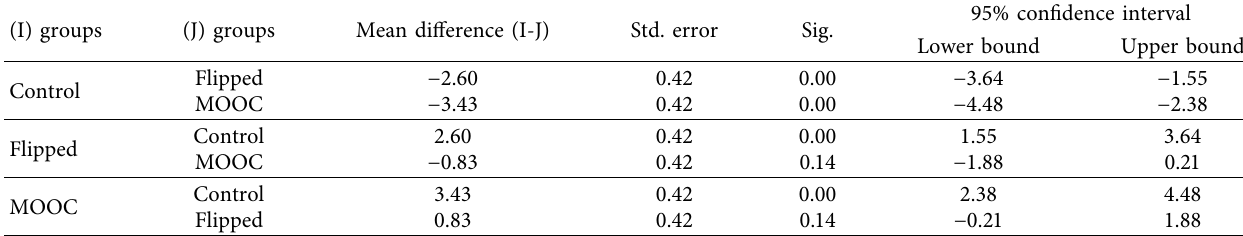
Table 5: Post hoc Scheffe test, multiple comparisons (posttest of reading